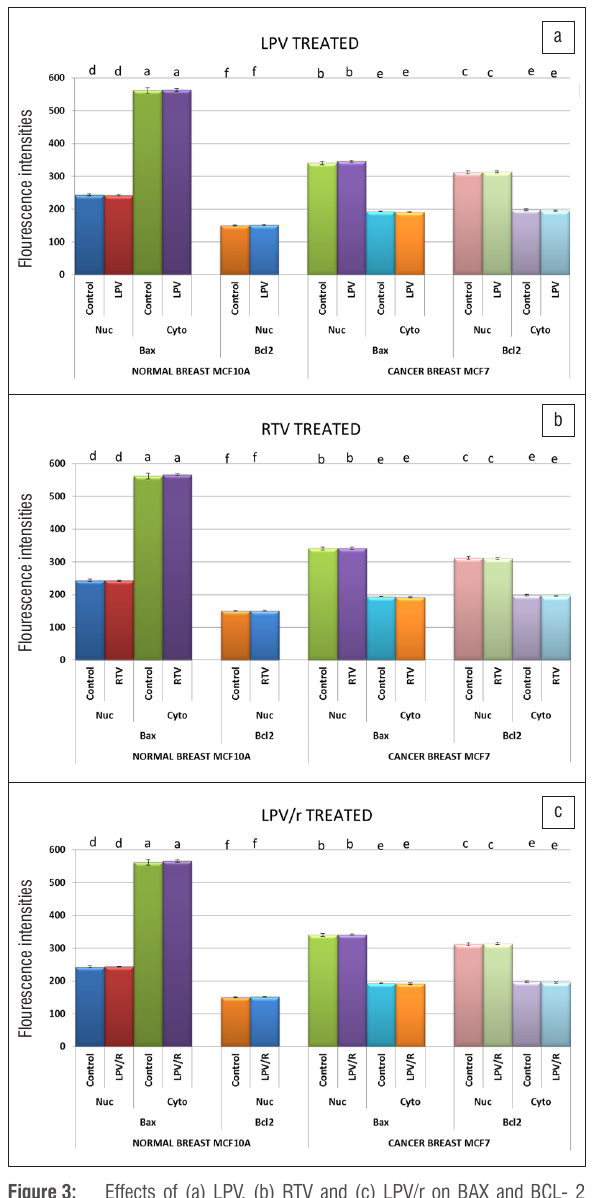
Figure 3: Effects of (a) LPV, (b) RTV and (c) LPV/r on BAX and BCL - 2 protein expression in normal breast (MCF-10A) and breast cancer (MCF-7) cells. Cells were incubated with 9.8 µg/mL LPV, 0.6 g/mL RTV and 9.8 µg/mL LPV/0.6 µg/mL for 96 h. Data (mean±SEM), are represented as fluorescence intensities of protein expression relative to values from the vehicle-treated cells and representative of 3 independent experiments for immunofluorescence staining. Groups not connected by the same letter are significantly ( p <0.05) different from each other.